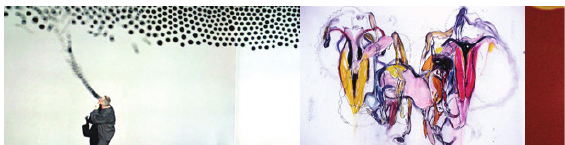
Figure 2 : Golan’s projects